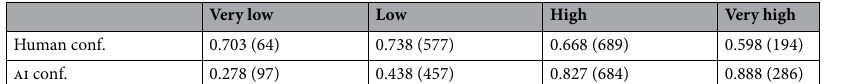
Very low Low High Very high Human conf. ai conf. Table 4. Change in agreement between endoscopists’ and ai, measured as the amount of times each endoscopist changes its opinion and follows ai’s suggestion. We report proportions and sample sizes of the change in agreement for different human confidence levels ( S1 ) and the ai perceived confidence levels, respectively.